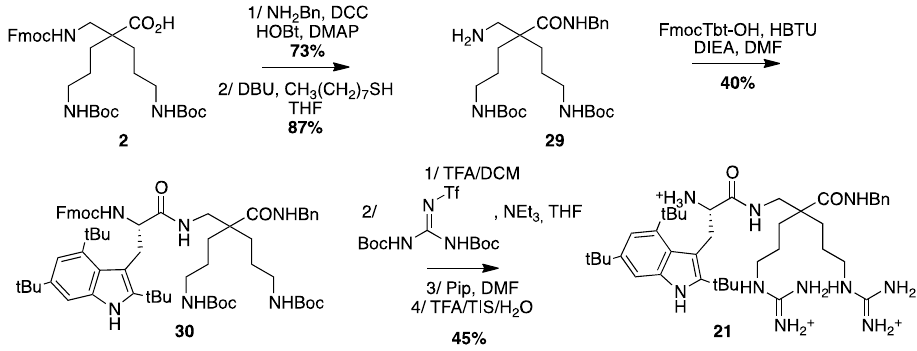
Figure 23 . HPLC profile of H-Tbt- β 2,2 h bis-Arg-NHBn 21 . Figure 23. HPLC profile of H-Tbt -